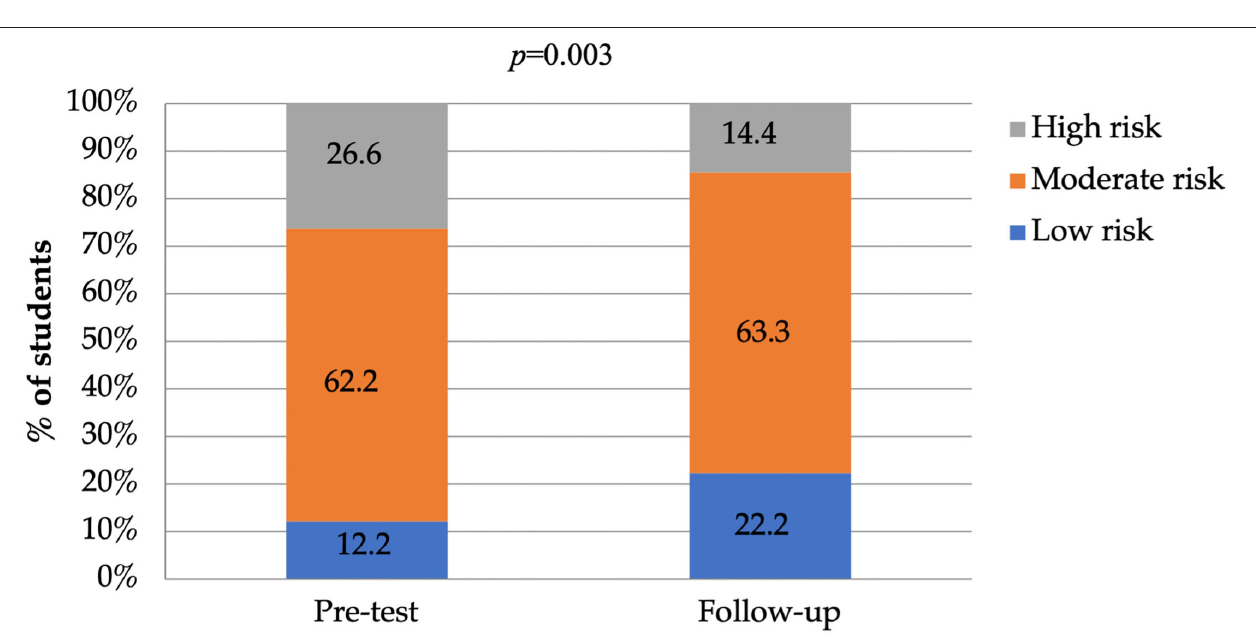
Findings in a study among adult consumers in Lebanon revealed much lower proportion for checking food labels than those reported in the UAE; stating that food labels are not adequately utilized by participants (30). Therefore, an awareness of the health risks associated with high salt consumption